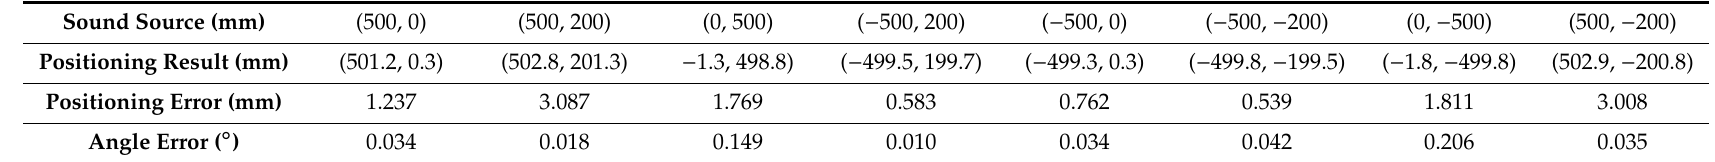
Table 1. The positioning test results with di ff erent angles.